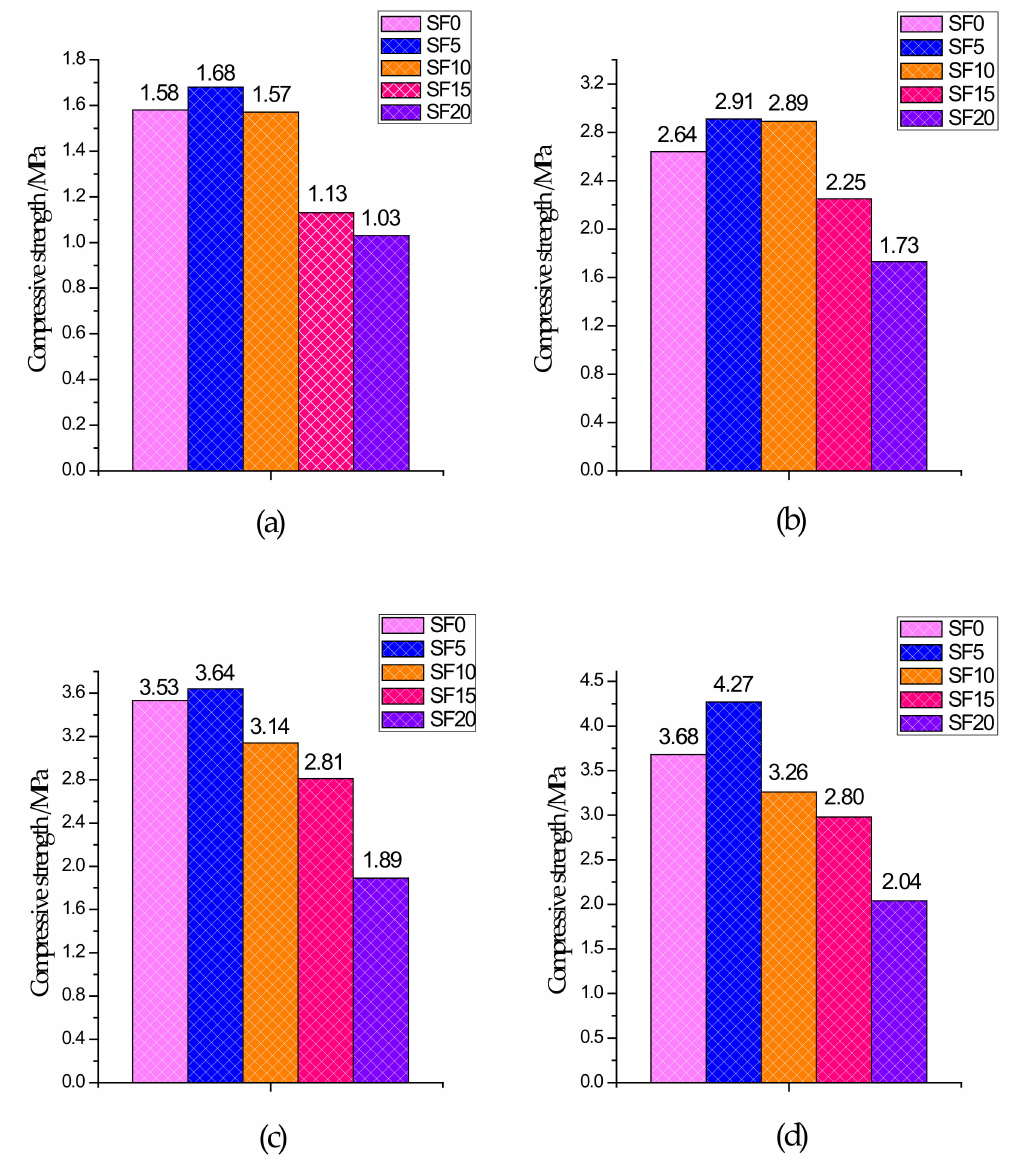
Figure 3. Compressive strength of di ff erent groups: ( a ) 3 days; ( b ) 7 days; ( c ) 14 days; and ( d ) 28